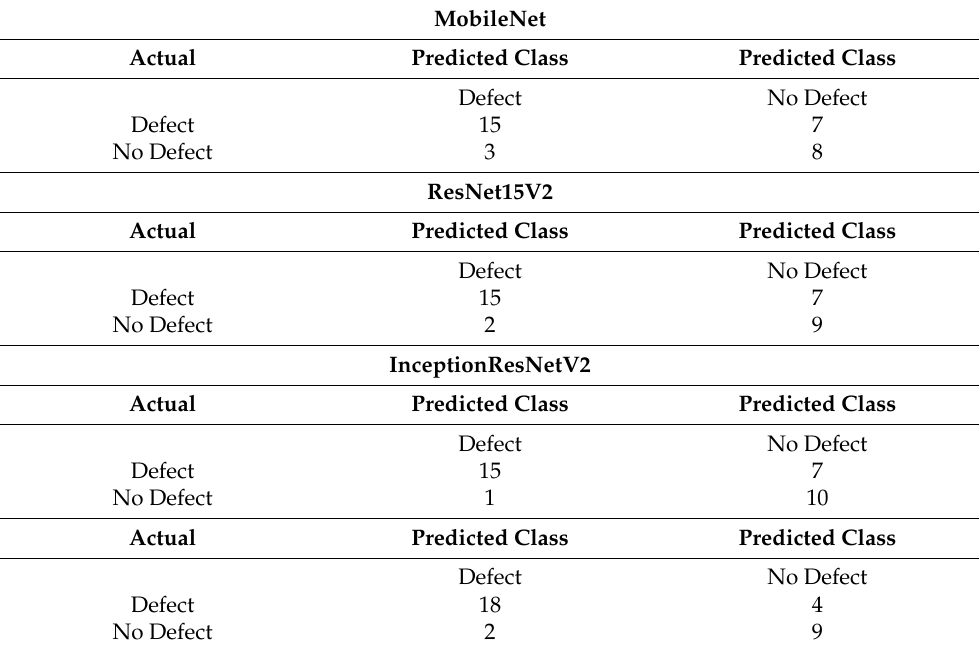
Table 8. Combined confusion matrices for defect recognition